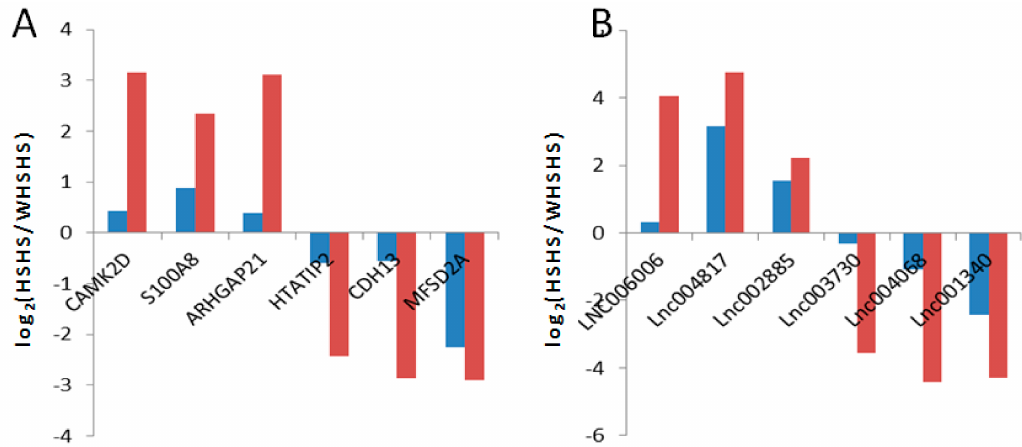
Figure 2. Validation of the di ff erentially expressed mRNAs and lncRNAs by qPCR. ( A ) The qRT-PCR results of the di ff erentially expressed mRNAs were compared with the RNA-Seq. Red: RNA-Seq; Blue: qRT-PCR. ( B ) The qRT-PCR results of the di ff erentially expressed lncRNAs were compared with the RNA-Seq. Red: RNA-Seq; Blue: